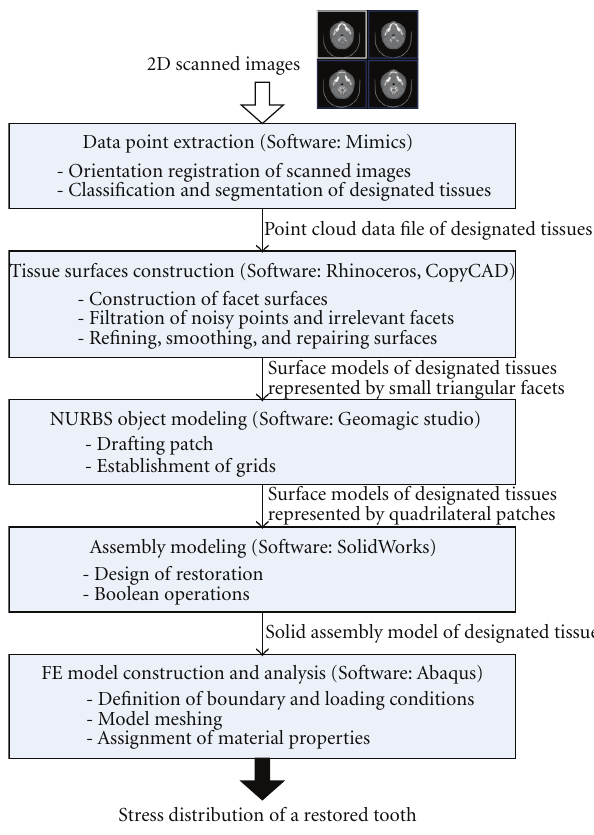
Figure 1: The five-procedure method in generating a 3D CT-based FE model from 2D scanned